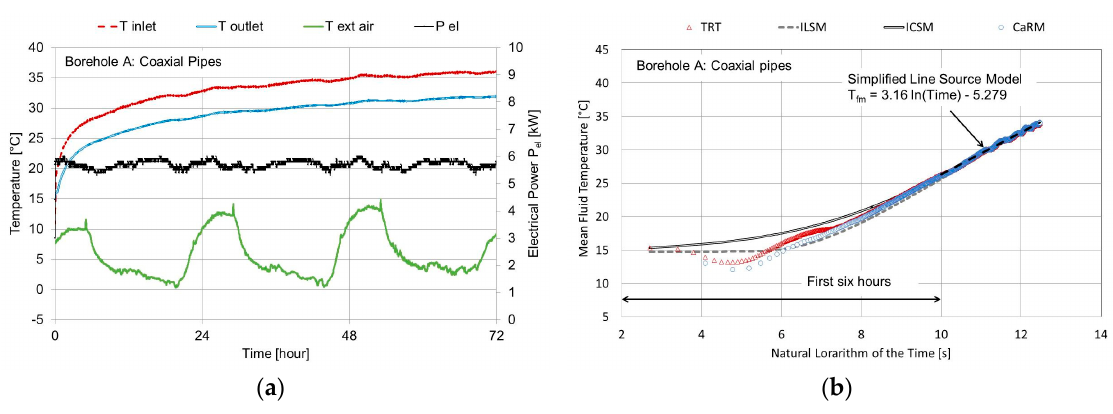
Figure 4. Thermal response test of the Borehole A which was 96 m long: ( a ) Test measurements; ( b ) Analysis with analytical and numerical models.